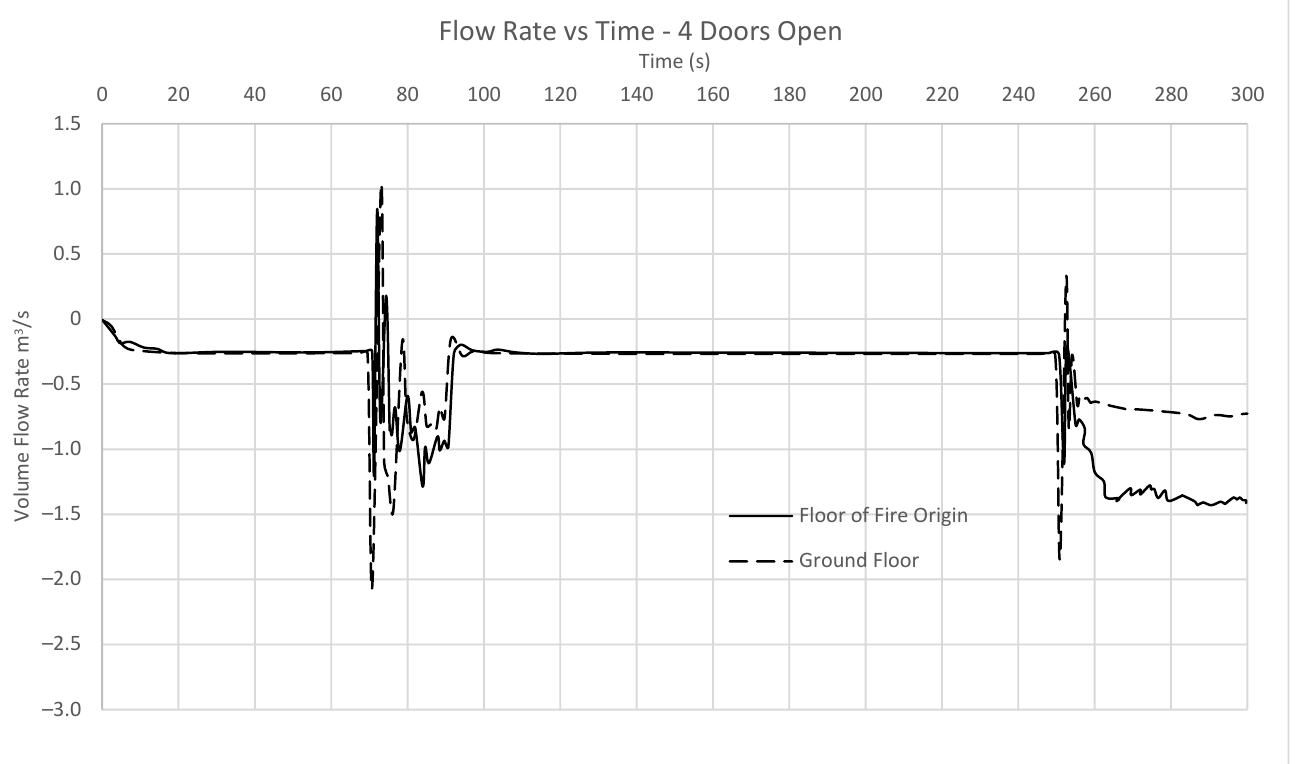
Figure 7. Volume flow rates through the ground floor door and floor of fire origin with four doors open into the shaft.